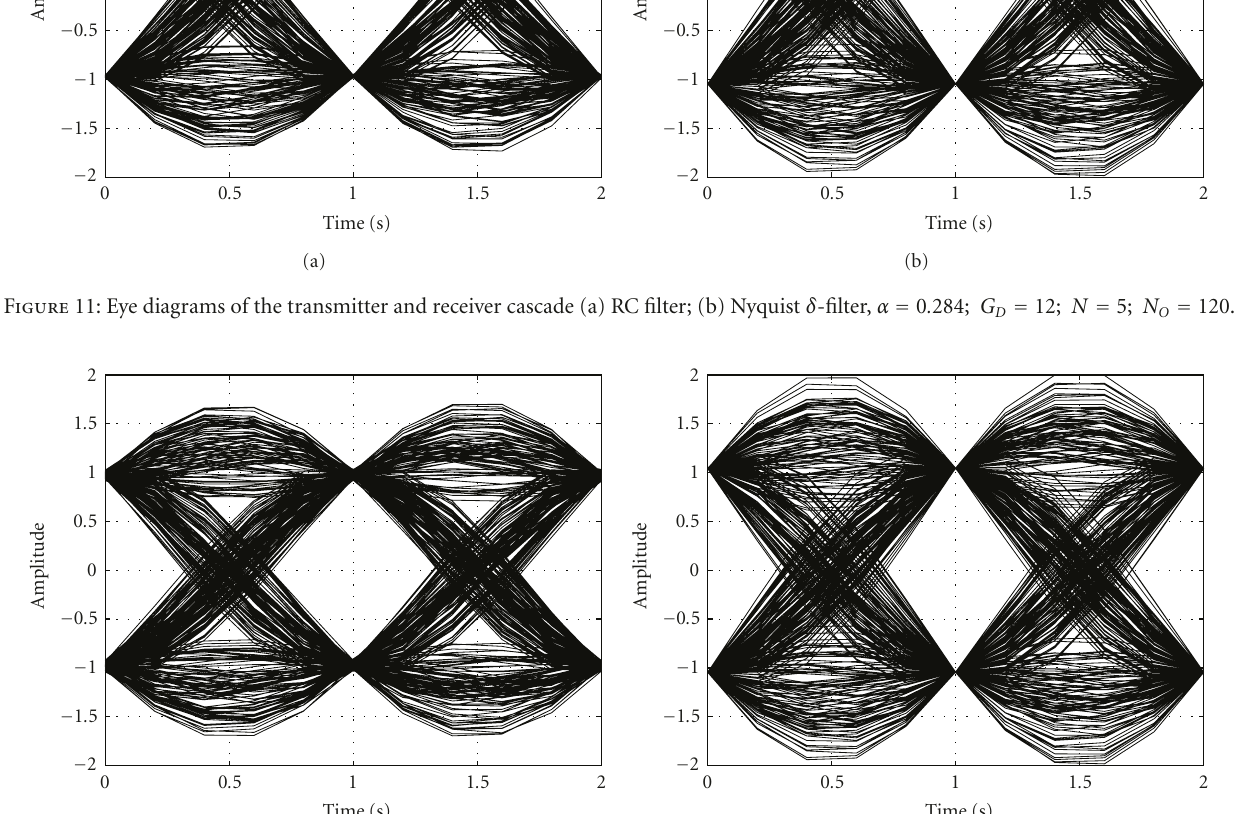
are of linear-phase having symmetrical impulse responses, which directly contribute to e ffi cient hardware realization